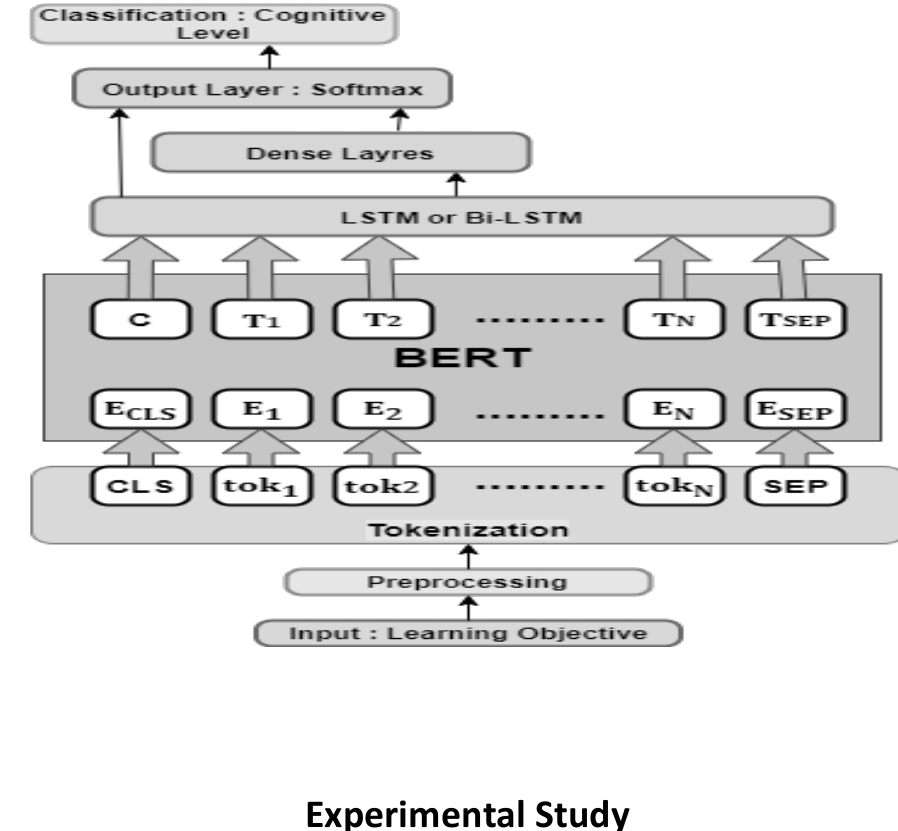
BERT With Fully Connected Layers and Deep Network Layers